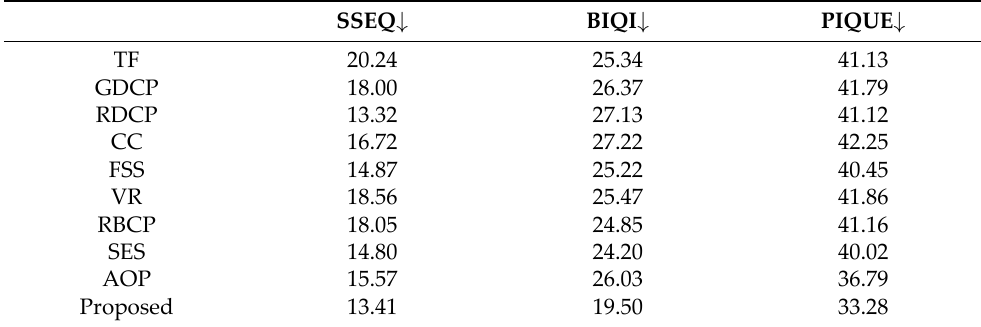
Table 4. Quantitative comparison of average SSEQ, BIQI, and PIQUE scores for the comparison algorithms on test set NSI.